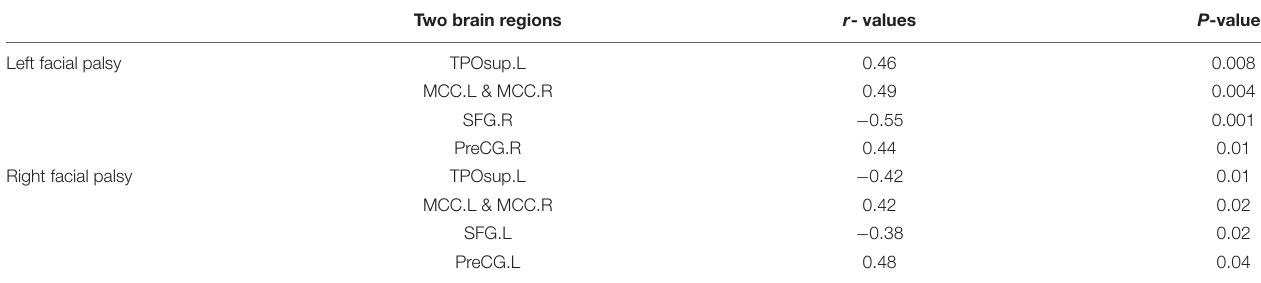
TABLE 3 | Brain regions showed correlation between fALFF value and TFGS score. Two brain regions r - values P -values